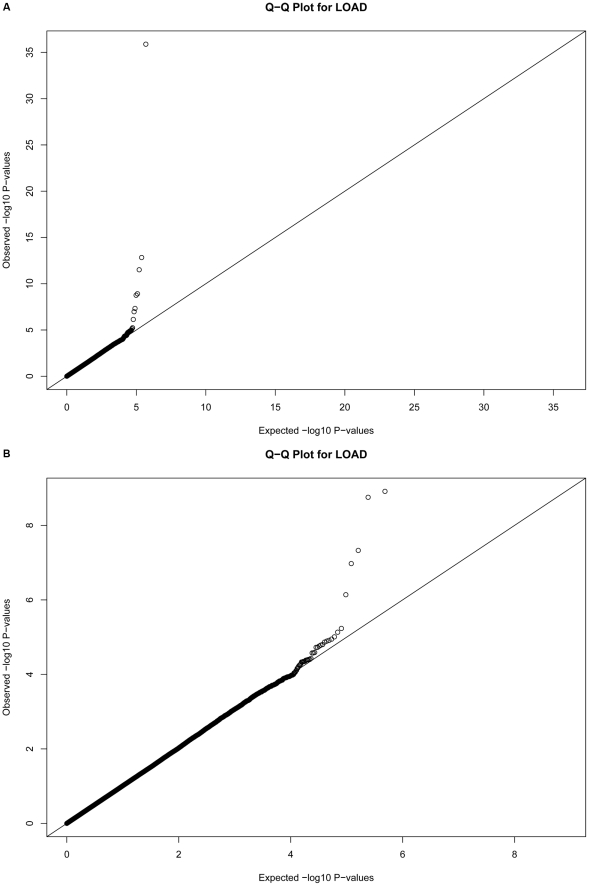
Quantile-Quantile plots for 483,399 single SNP tests of association.Plots depict expected versus observed −log10 P-values for 483,399 single SNP tests of association (in 931 LOAD cases and 1,104 cognitive controls, with adjustment for principal components as covariates for population substructure). Plot A includes the most-strongly associated SNPs within the APOE locus, whereas plot B excludes the three most-strongly associated SNPs for clarity.